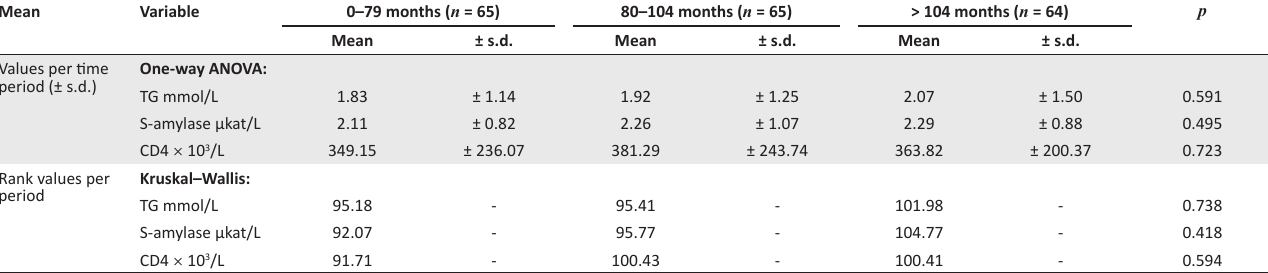
TABLE 3: Difference between mean and mean-ranked values per time period since human immunodeficiency virus diagnosis. Mean Variable 0–79 months ( n = 65) 80–104 months ( n =